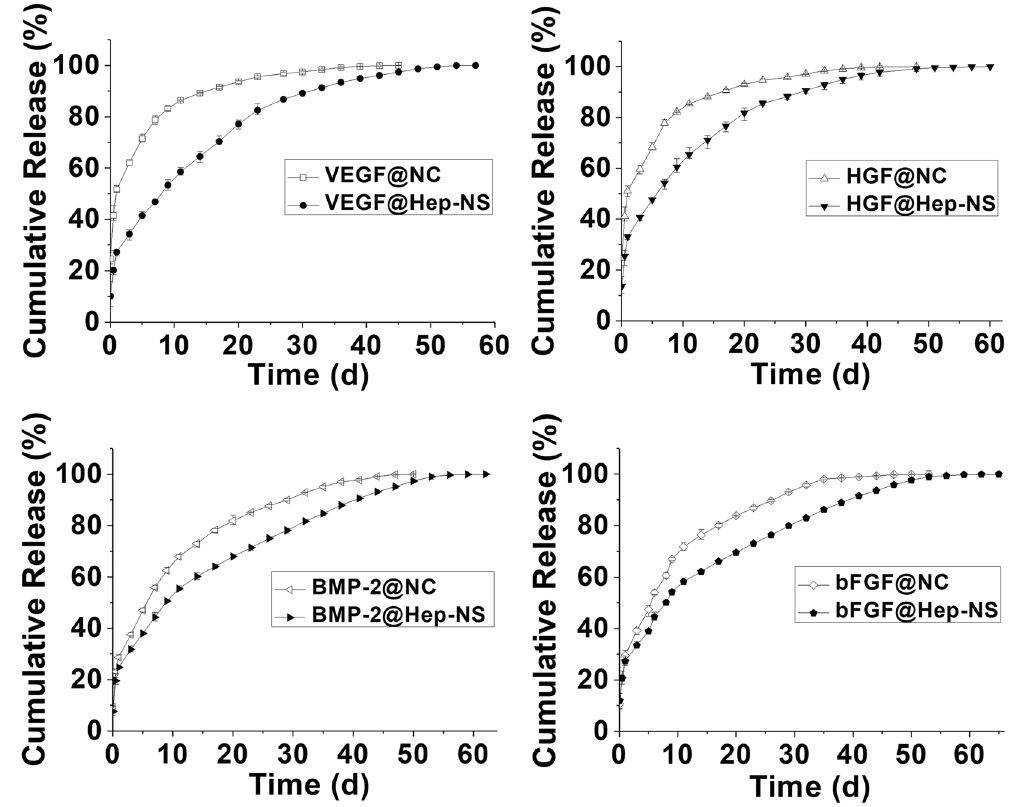
Figure 5. Release profiles of four different growth factors (VEGF, HGF, BMP-2, and bFGF) from the nanosponge (Hep(24)-NS) and their comparison with nano-carrier (NC) (n =